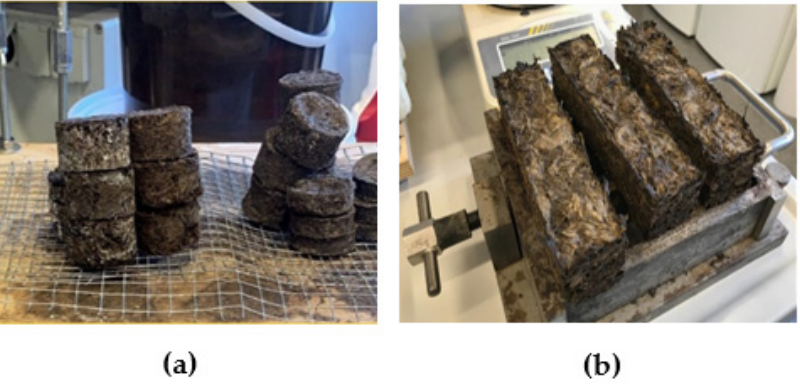
Figure 2. Developed material samples: ( a ) Samples for sound absorption and microbiological resistance tests; ( b ) Samples for mechanical strength tests.